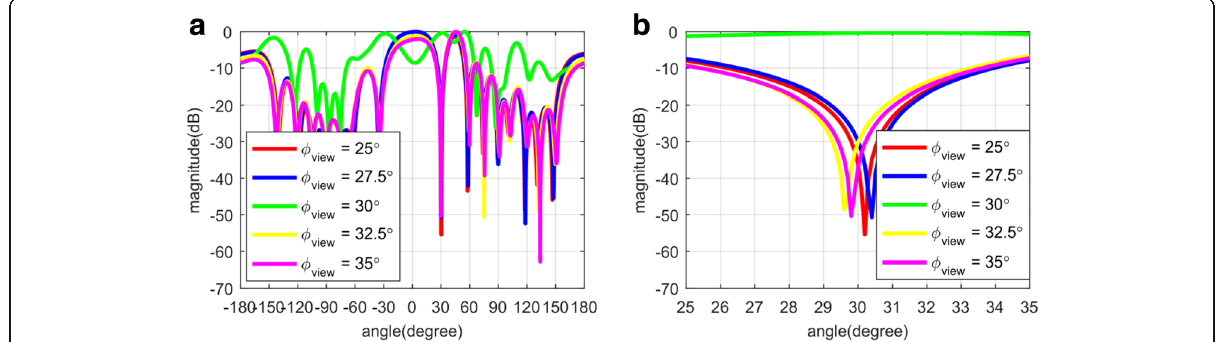
Fig. 2 Beam patterns of the beam amplitude responses with different view directions. a In the angular interval of [ − 180 ∘ , 180 ∘ ]. b In the angular interval of [25 ∘ , 35 ∘